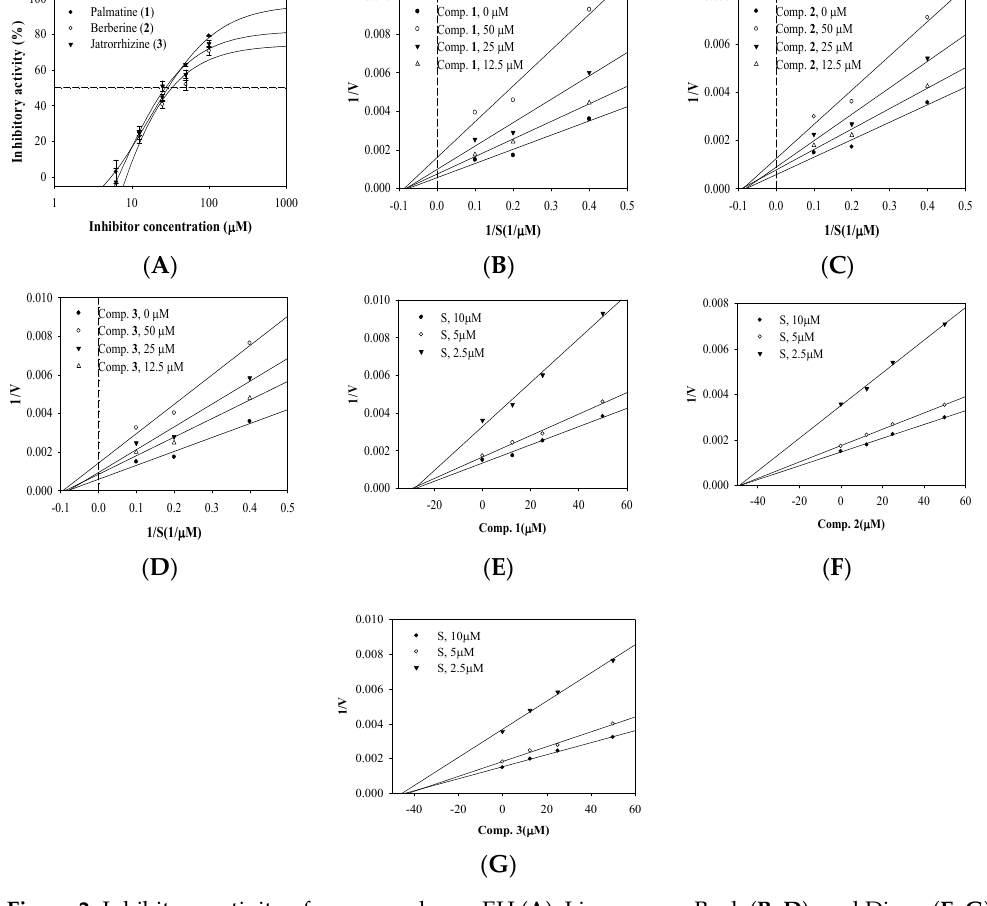
Figure 2. Inhibitory activity of compounds on sEH ( A ), Lineweaver–Burk ( B – D ), and Dixon ( E – G ) plots of sEH inhibition by compounds, respectively.